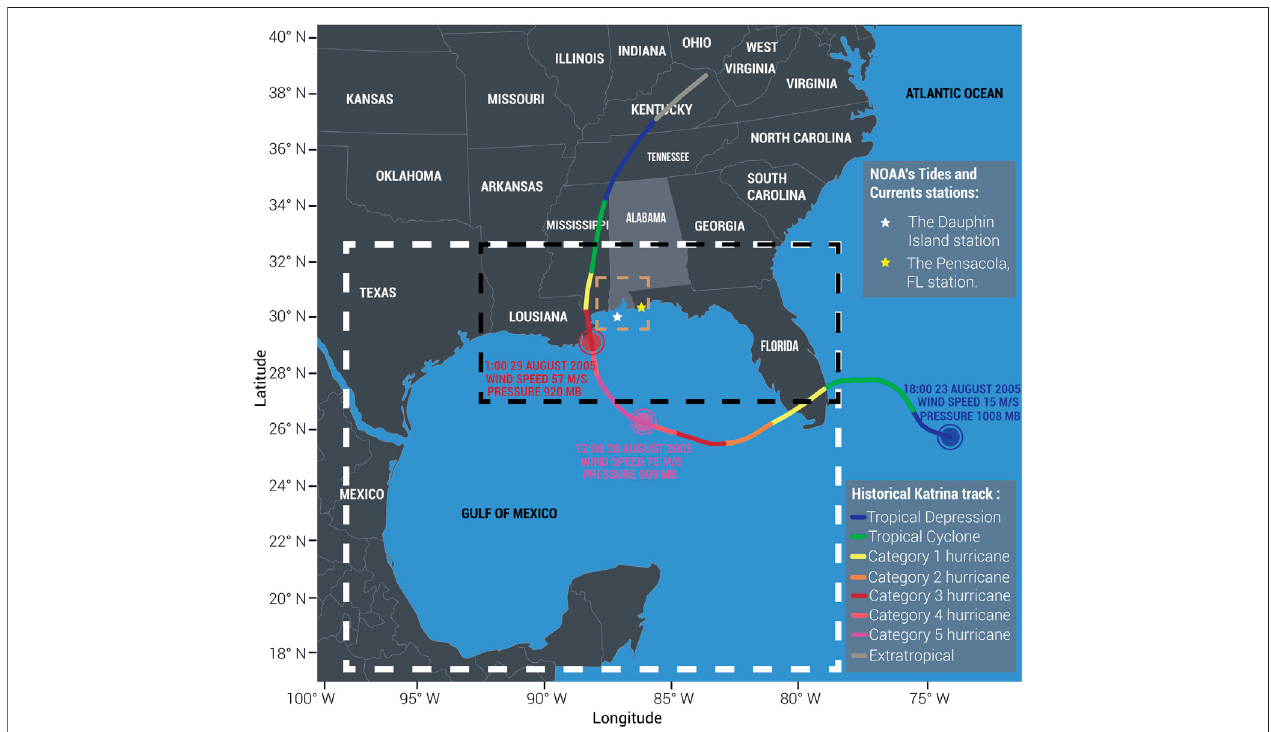
FIGURE 8 | Modeling domains with Katrina natural track and tides observation stations used in this study.